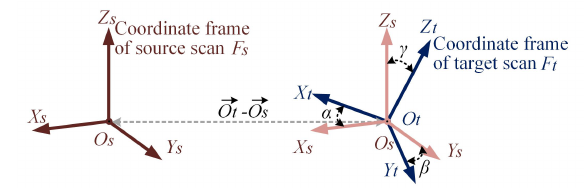
Figure 5. Estimating transformation parameters